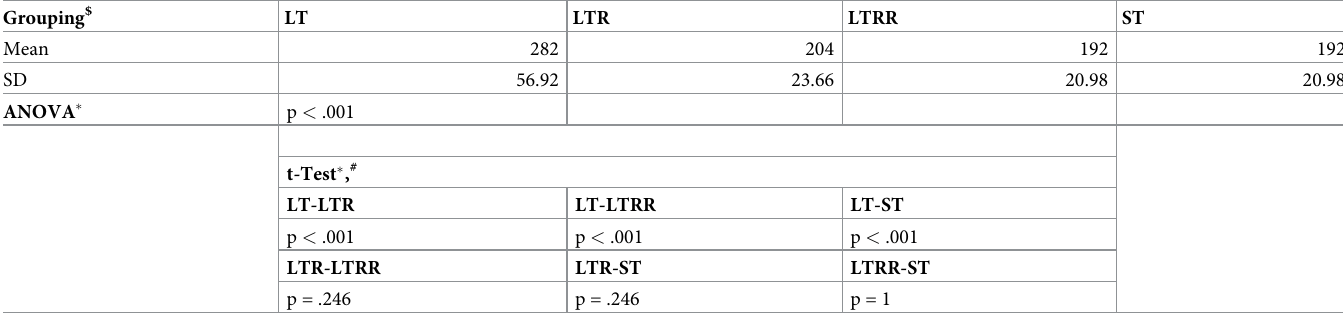
Table 1. Crown removal time (sec) and statistical